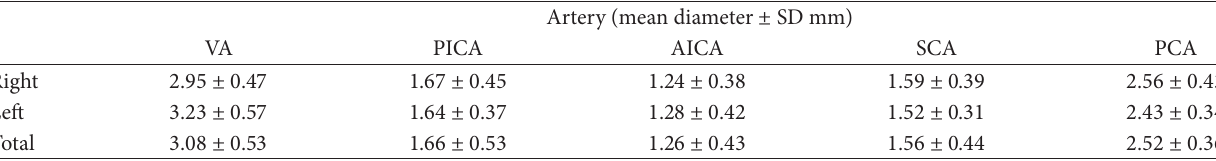
Table 1: Diameters of the branches of vertebrobasilar